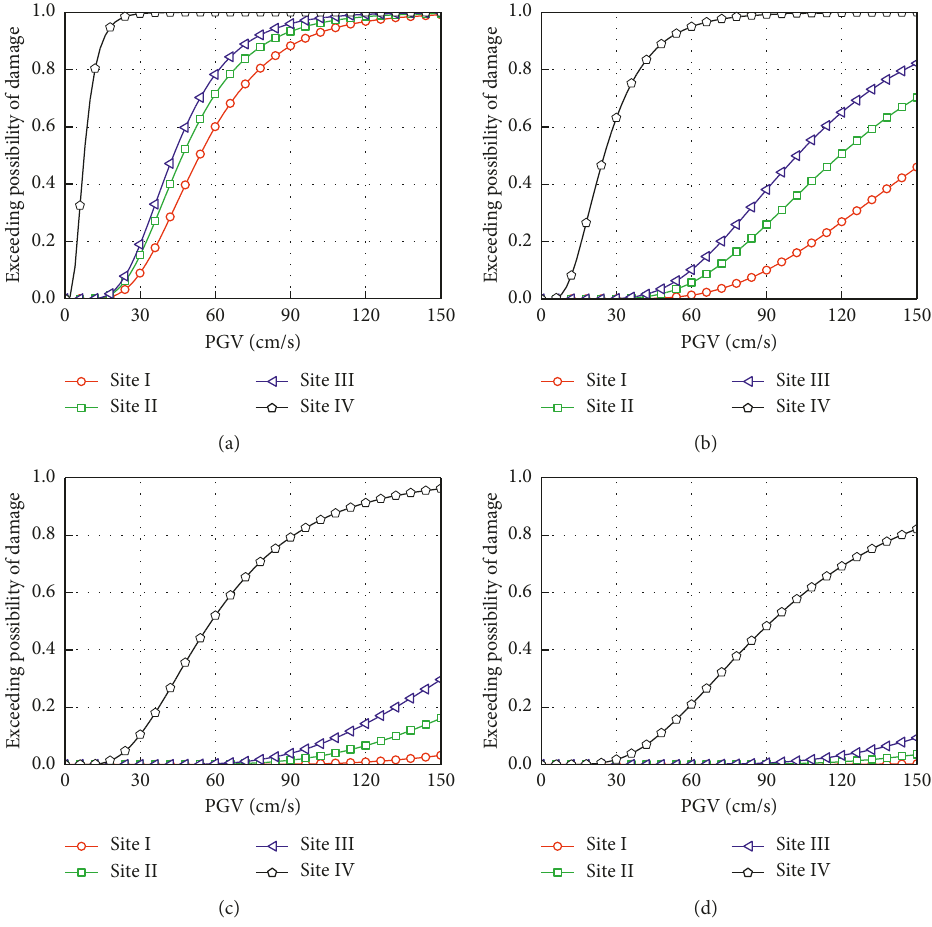
Figure 15: Comparison of fragility curves of different sites under different performance levels: (a) FO, (b) OP, (c) LS, and (d)